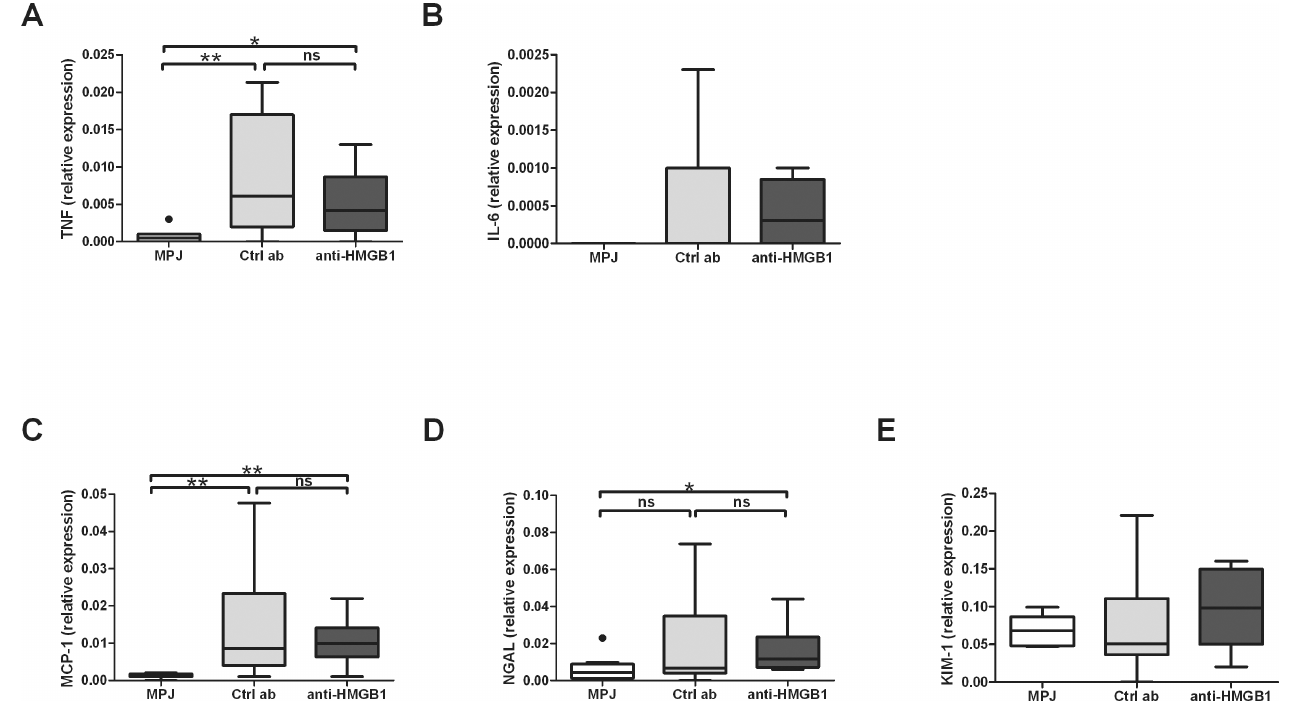
Figure 6. Anti-HMGB1mAb treatment of MRL/lpr mice does not affect renal mRNA levels of IL-6, TNF, MCP-1, NGAL or KIM-1. Expression levels of TNF- α (A), IL-6 (B), MCP-1 (C), NGAL (D) and KIM-1 (E) mRNA were analyzed in kidney tissues of MRL/MPJ mice (n = 8) and MRL/lpr mice treated with control (n = 11) and mice treated with monoclonal anti-HMGB1 (n = 9). Data are shown as relative expression compared with GAPDH. Box and whiskers plot, median and interquartile range are shown. Separate dots indicate outliers. A Krus- kal-Wallis test was used to test for overall differences between the three groups. To investigate which group was different, further testing was performed to compare groups separately using a Mann-Whitney U test. * p < 0.05; ** p < 0.01. ns,